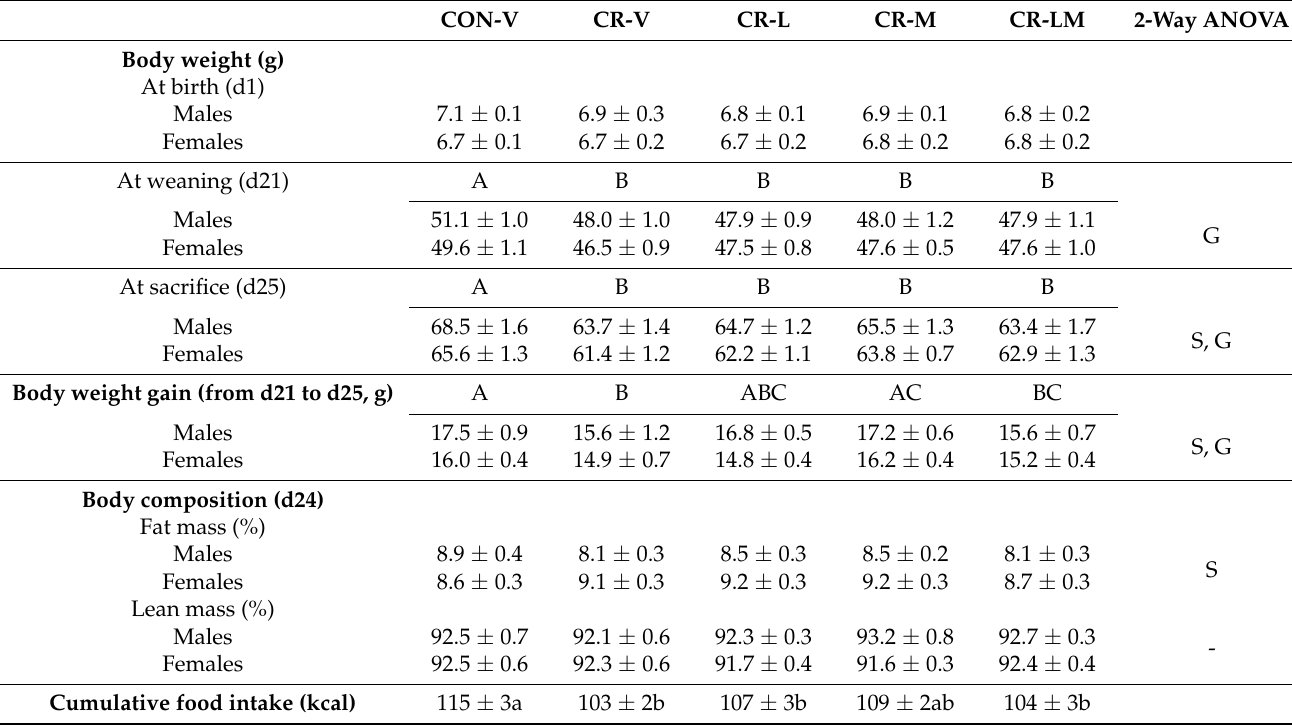
Table 1. Food intake and body weight and composition related measurements of 25-day-old male and female offspring of control (CON) and 25% gestational calorie-restricted (CR) dams. Data are means ± s.e.m ( n = 15–18). Statistics: Two-way ANOVA was performed to assess the effects of sex and group (CON-V, CR-V, CR-L, CR-M, and CR-LM). One-way ANOVA was carried out to determine differences between groups. ANOVA was followed by a least significant difference (LSD) post-hoc test. Symbols: S, effect of sex; G, effect of group; A (cid:54) = B (cid:54) = C ( p < 0.05, two-way ANOVA); a (cid:54) = b ( p < 0.05, one-way ANOVA). Abbreviations: vehicle (V), leptin (L), myo-inositol (M), leptin and myo-inositol